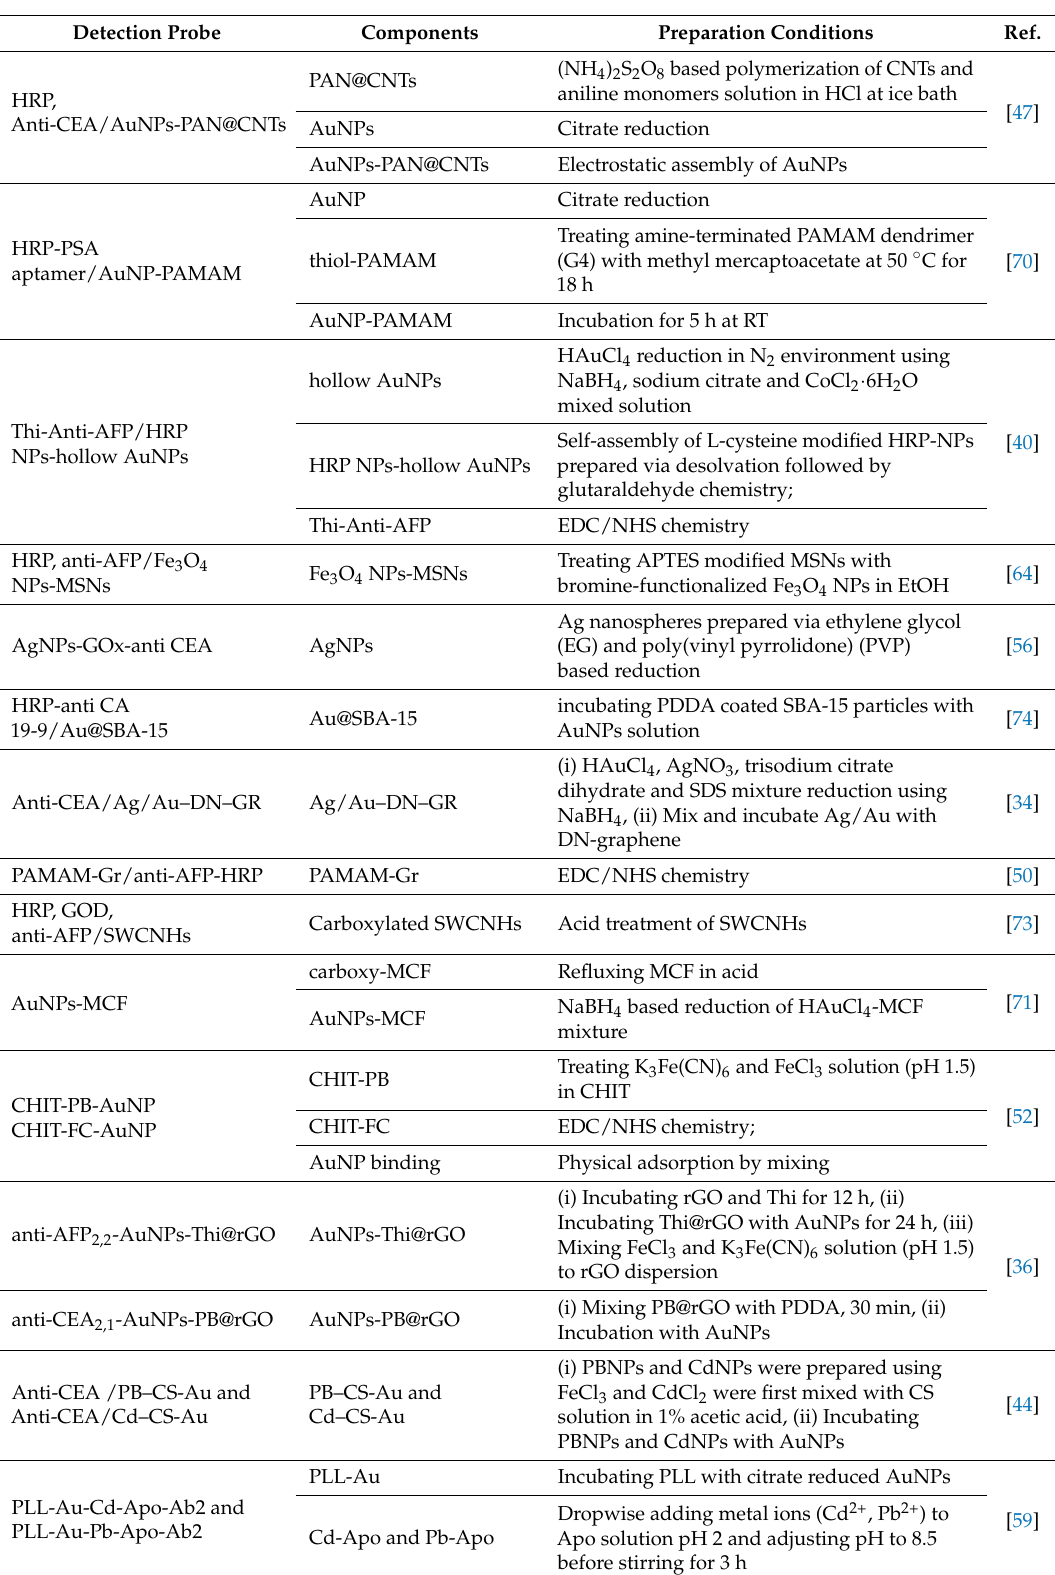
Table 2. Strategies used for the development of detection probes for enhanced